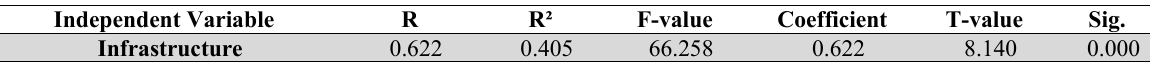
Results of SLR test of infrastructure on OP